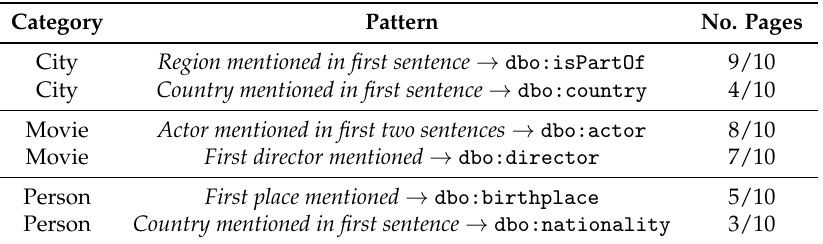
Table 1. Examples for patterns observed on pages for cities, movies, and persons. Those patterns were manually found on ten random pages about cities, movies, and